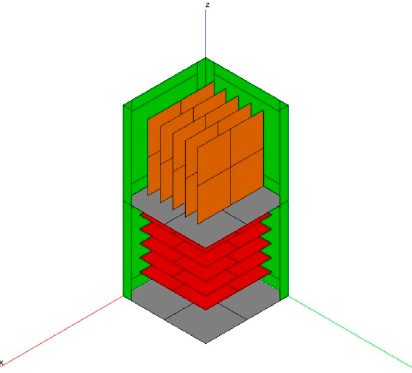
Figure 14. View on the internal thermal model with payload PCBs (orange) and the PCBs of the satellite